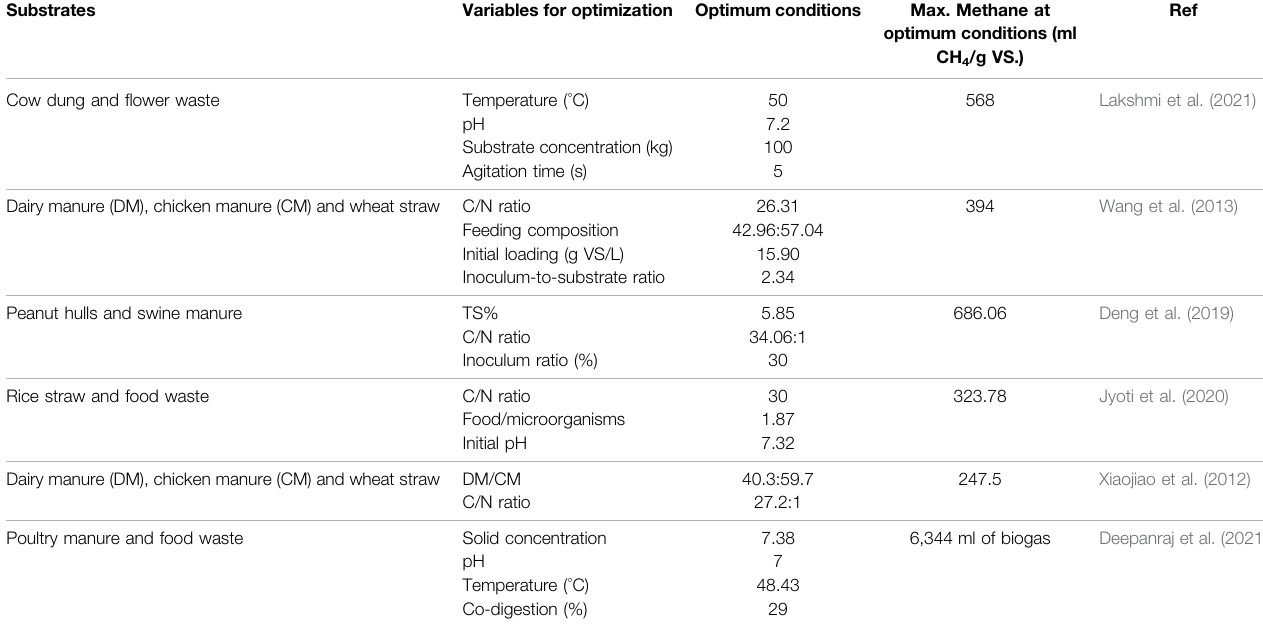
TABLE 2 | AcoD parameters optimization using RSM. Substrates Variables for optimization Optimum